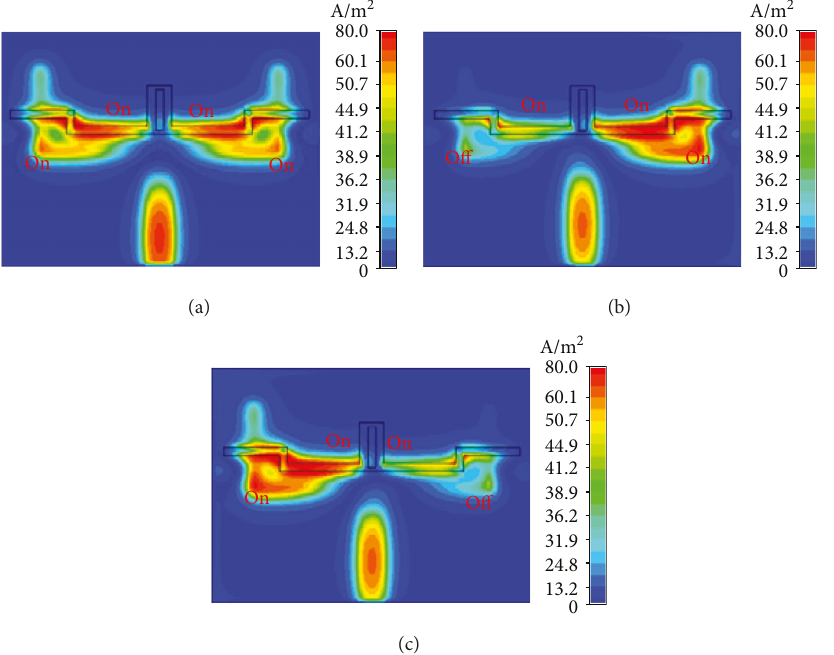
Figure 5: Surface current distributions. (a) Mode 4. (b) Mode 5. (c) Mode